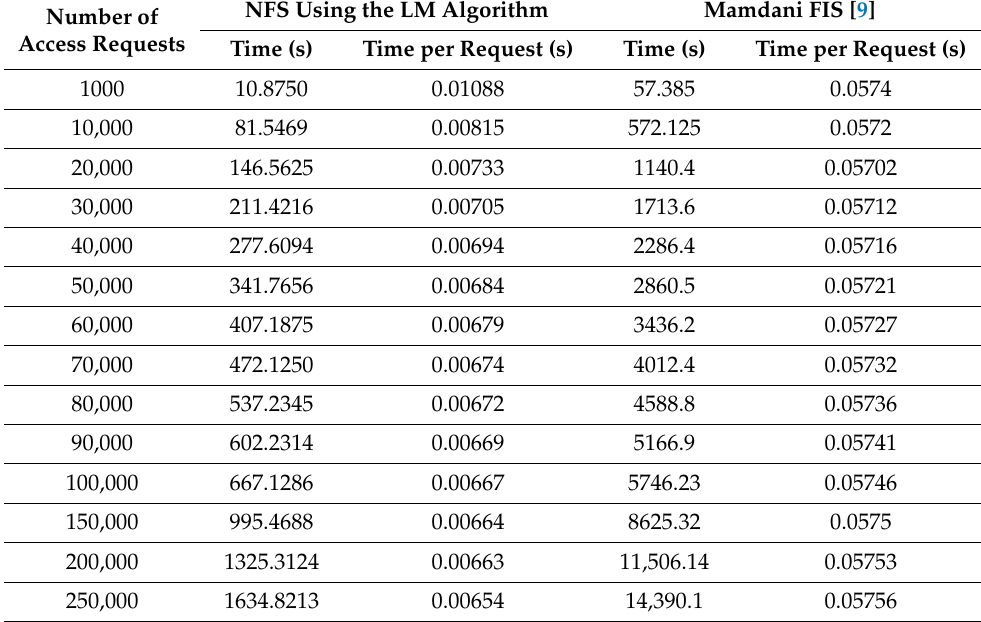
Table 6. Processing time of the NFS model using the LM learning algorithm and Mamdani